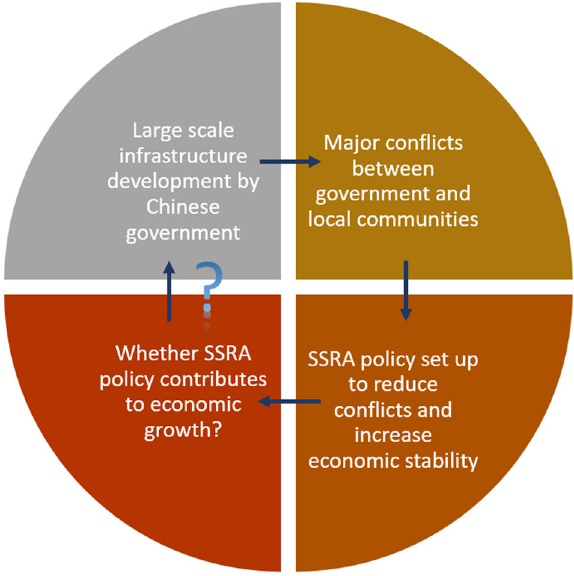
Fig. 2 Research logic identifying the research question for this study. The arrow shows the development process of SSRA policy. The question mark illustrates the core issue of our